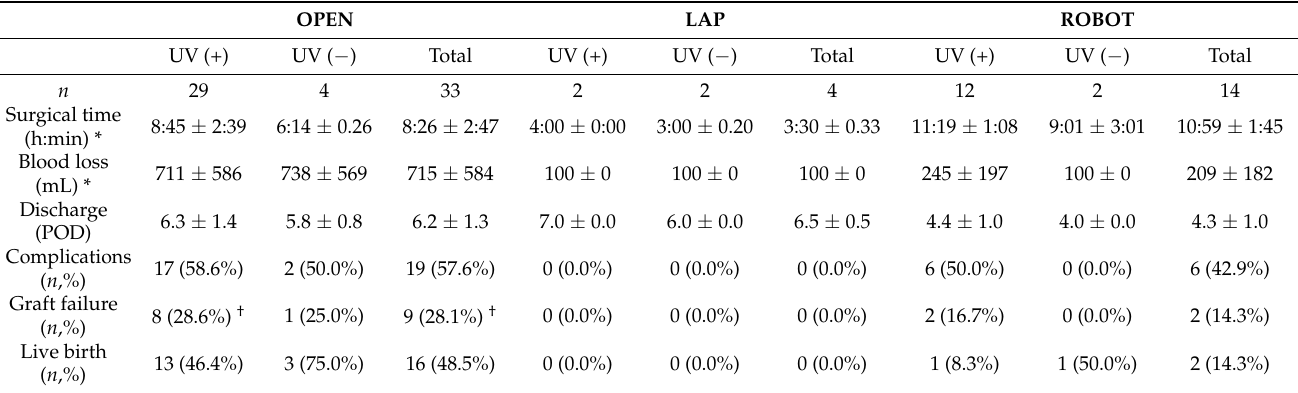
Table 2. Operative and clinical data for each operative approach with or without using the uterine vein. OPEN LAP